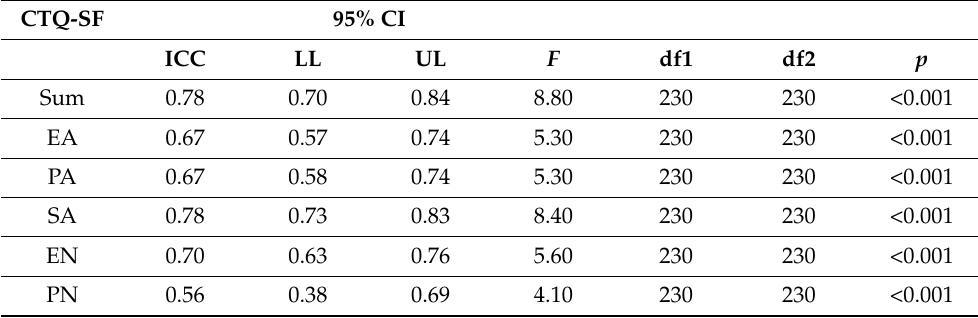
Table 3. Absolute Agreement between CTQ Self-Assessment and External Assessment in the Total